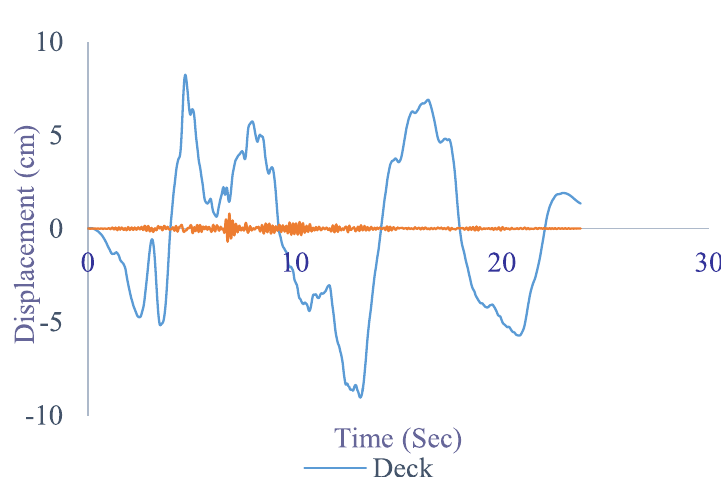
Fig. 19 The lateral displacement of points Deck and Cap beam in the longitudinal direction (X) in model 4 under the Tabas earthquake